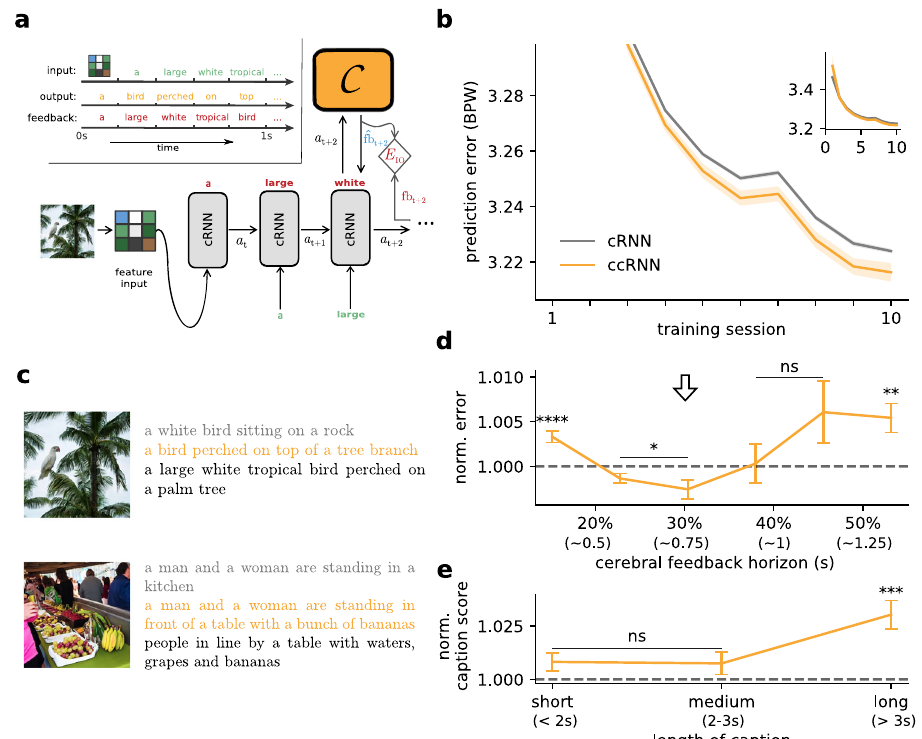
Fig. 8 | Cerebro-cerebellar model facilitates learning in a visual-language task. a Schematic of the model used in a visual-language task. The image is fi rst pro- cessedby a(pretrained)convolutionalneuralnetworkmodelling the visual cortex. TheresultingfeaturevectoristhenprovidedtothecerebralRNNwhichistrainedto predict the next word given the previous words of a provided “ gold standard ” imagecaption.Thecerebellummodule C isonlyappliedtothecRNN.Topleft:task structure with example input image and words (green), ccRNN output words (orange) and target caption (red). b Learning curves in bits per word (BPW), lower values indicate better understanding of the language on validation set for cerebral feedback horizon of four timesteps (inset shows complete learning curve). c Two